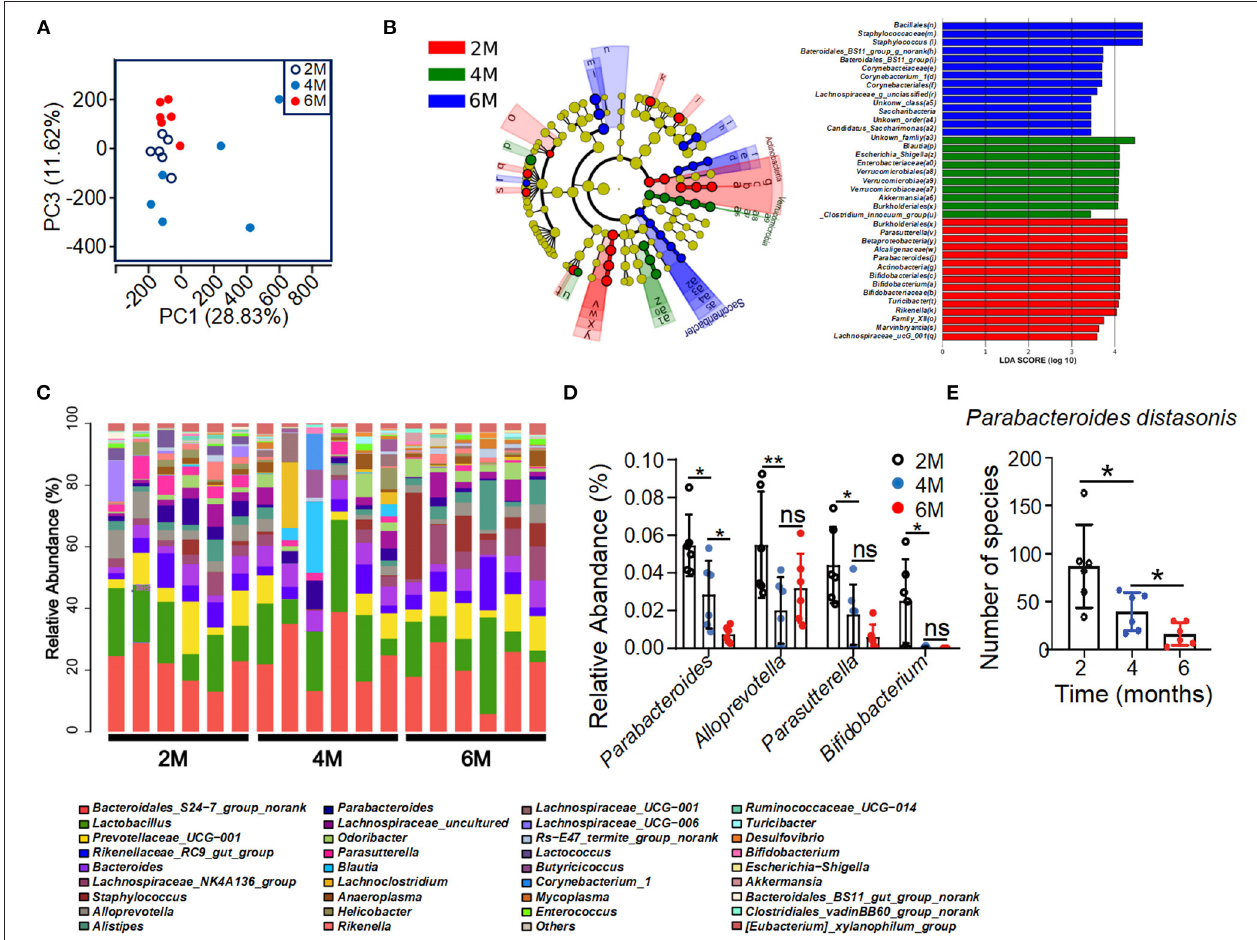
FIGURE 2 | Alteration of bacterial communities in feces of 2-, 4-, and 6-month-old K14-VEGF mice. (A) Principal coordinate analysis (PCoA) plot of the fecal microbiota of the 2-, 4-, and 6-month-old K14-VEGF mice ( n = 6 per group). (B) Bacterial 16S rRNA sequences in the 2-, 4-, and 6-month-old mice feces are depicted. The taxonomic cladogram showed the phylogenetic distribution of differentially enriched taxa among three groups. Fecal of 6 month-old-mouse-enriched taxa were presented in blue, fecal of 4-month-old mouse-enriched taxa in green, and fecal of 2-month-old mouse-enriched taxa in red, respectively. Only taxa meeting the criteria (LDA score > 4 and P < 0.05) were shown. Linear discriminant analysis (LDA) scores revealed bacterial taxa with obvious difference in feces from three groups. Taxa significantly enriched in 2-, 4-, and 6-month-old mice were depicted in red, green, and blue, respectively. (C) Gut microbial composition was evaluated in order to determine the relative abundance of genera at three groups. (D) Relative abundance of Parabacteroides , Alloprevotella , Parasutterella , and Bifidobacterium in total fecal microbiota in 2-, 4-, and 6-month-old mice. (E) Species number of Parabacteroides distasonis in 2-, 4-, and 6-month-old mice. Each symbol represented a mouse, and bars showed means and SEM. Statistical tests used were Student t -test in (E) . * P < 0.05 and ** P <